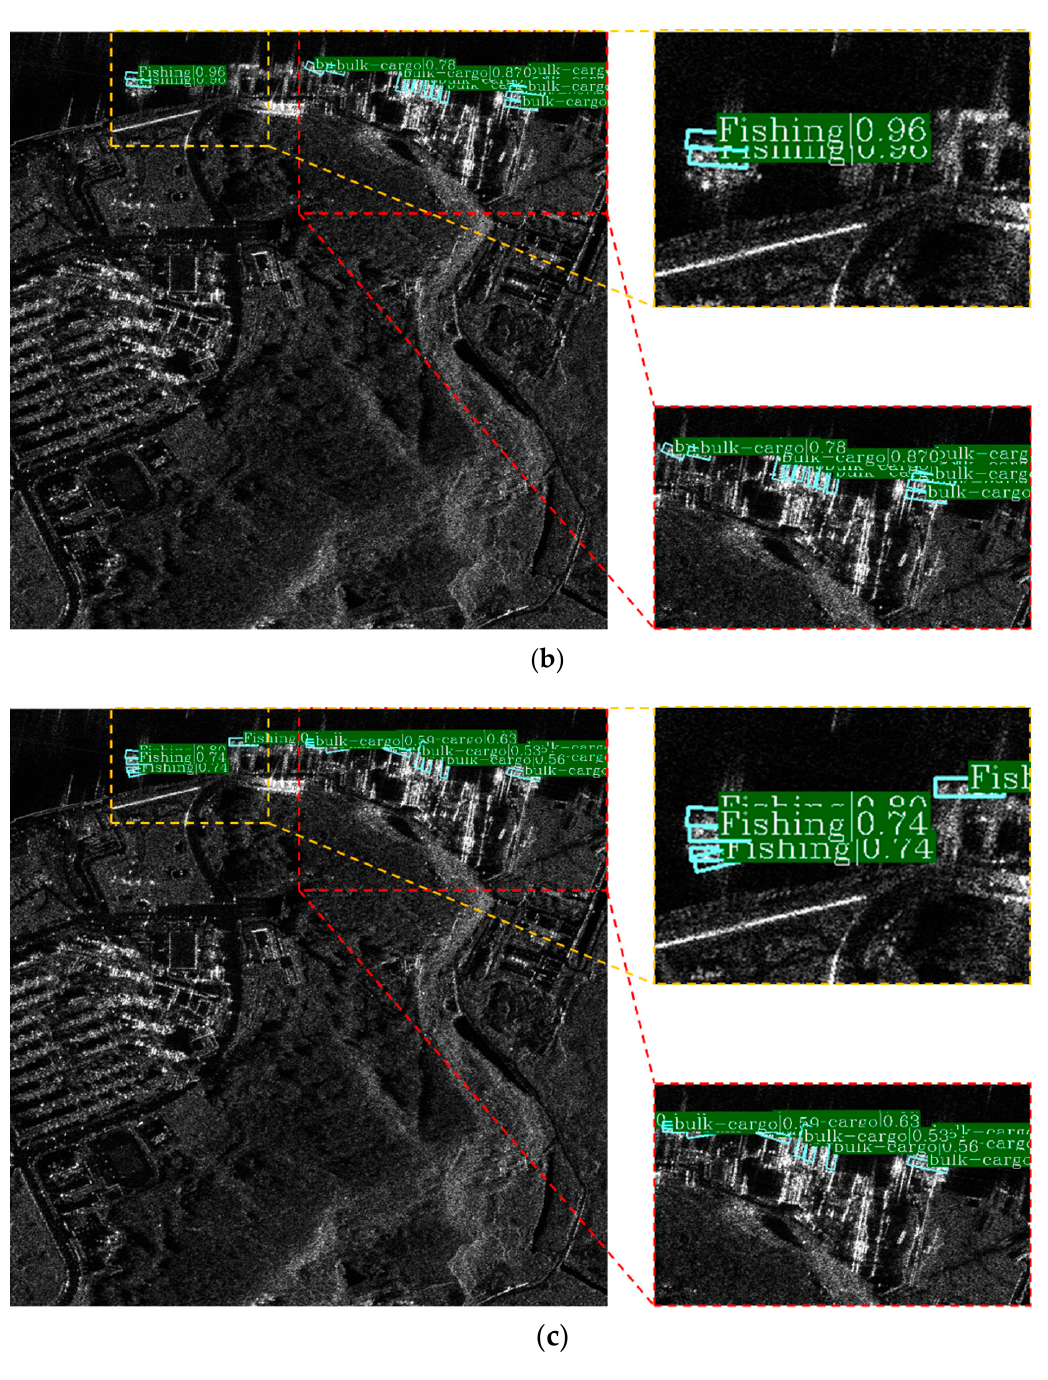
Figure 11. Detailed detection results. ( a ) Ground truth; ( b ) Result of O-RCNN; ( c ) Result of the proposed RBFA-Net.